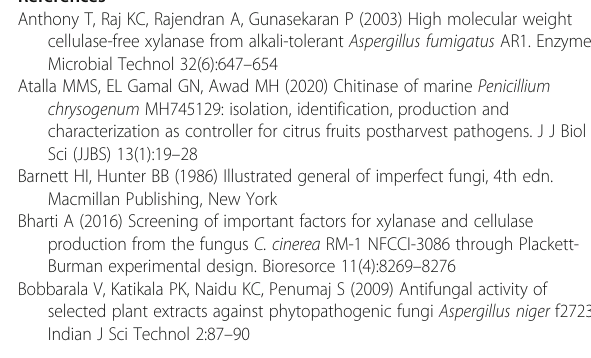
Figures with the same letter are not significantly different ( p =